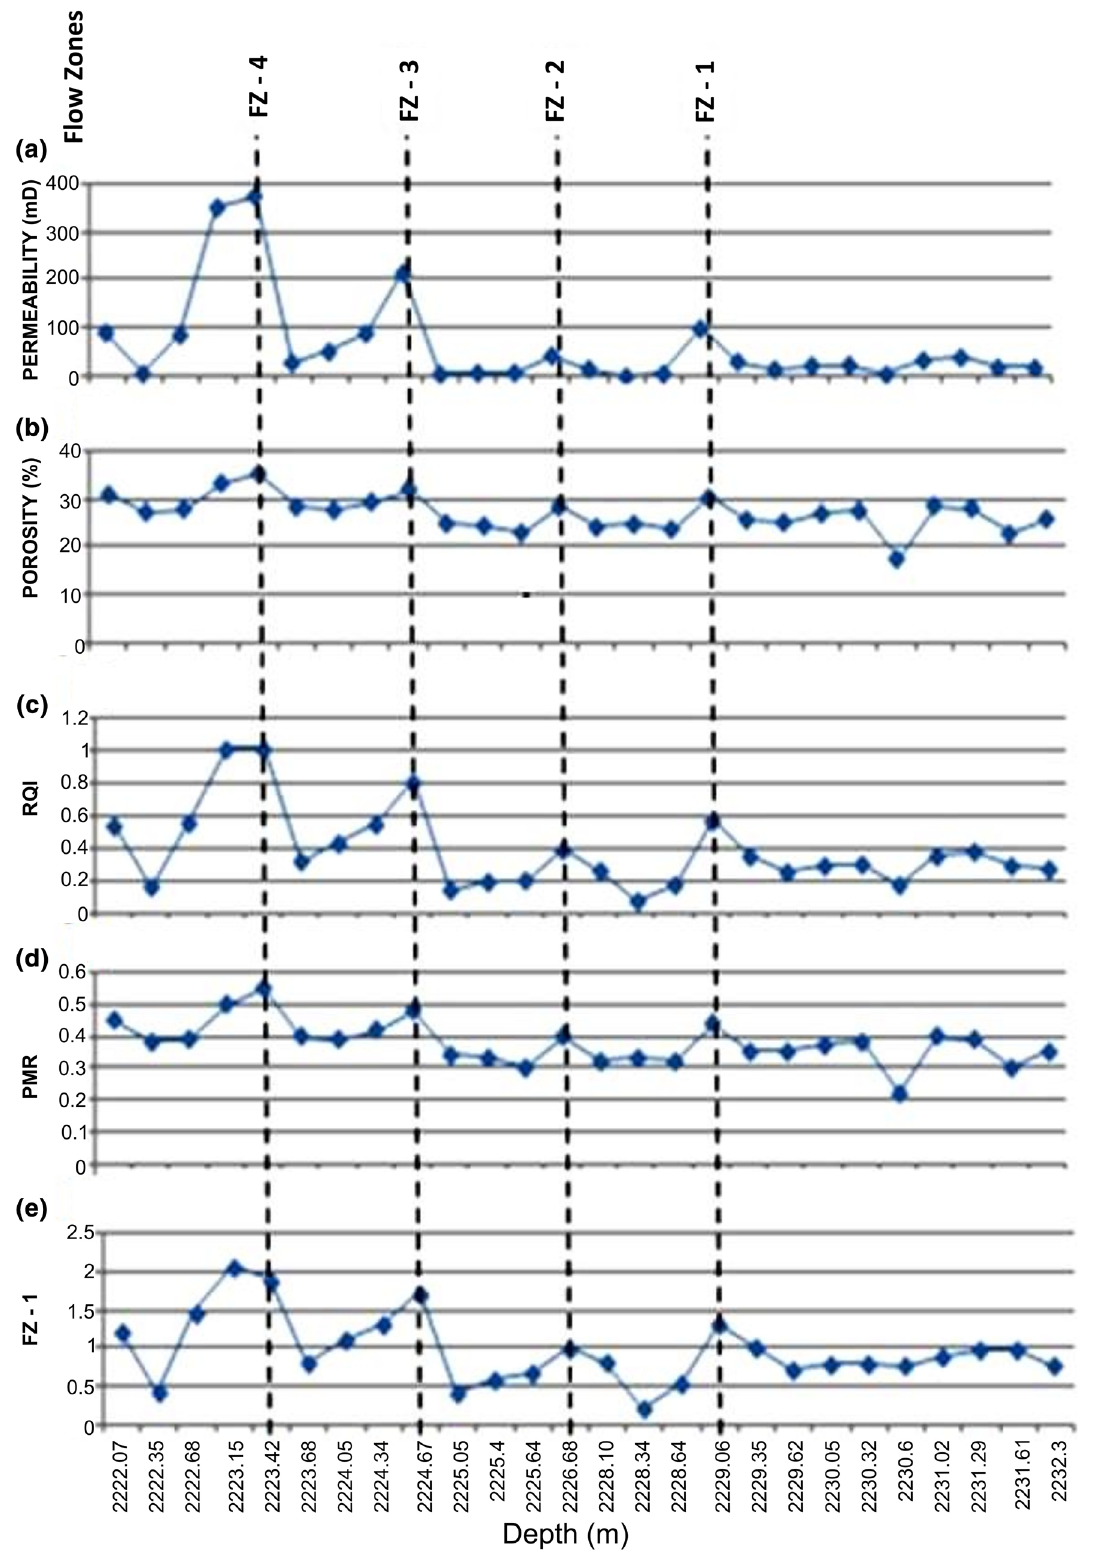
Fig. 7 Hydraulic flow units in the PZ-2